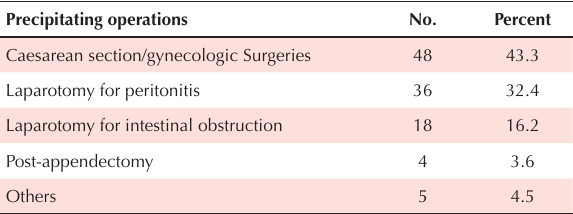
Table 3. Precipitating operations for adhesive intestinal obstruction Precipitating